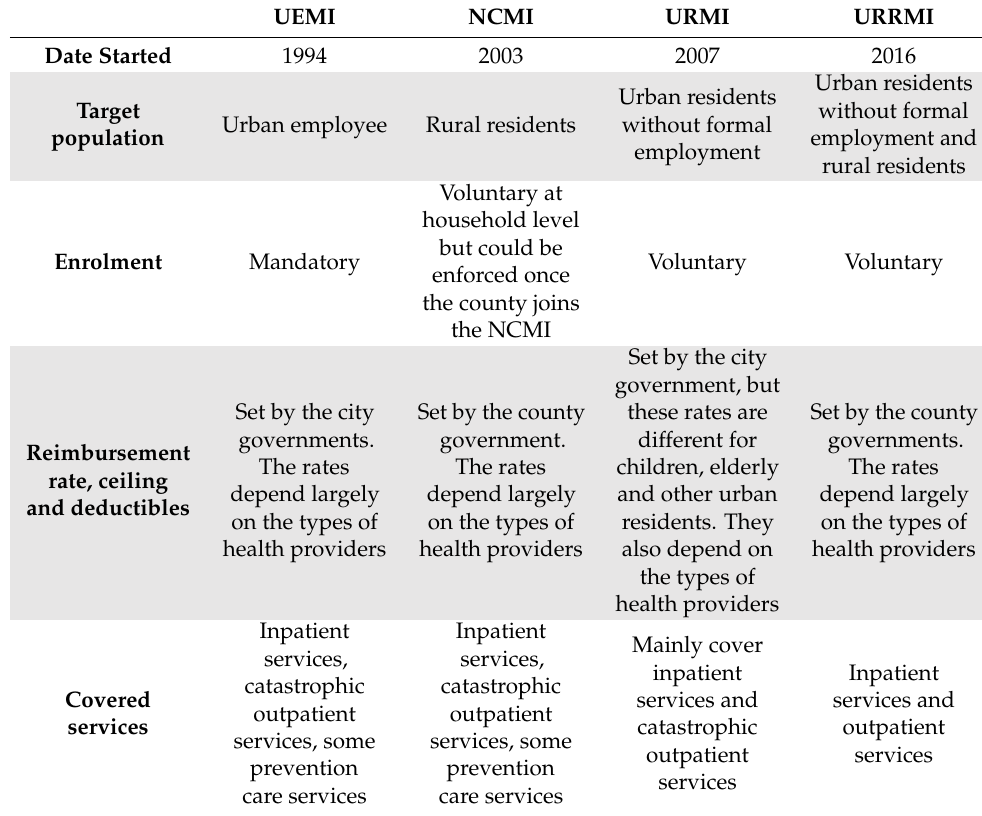
Table 1. The characteristics of four main types of basic health insurance